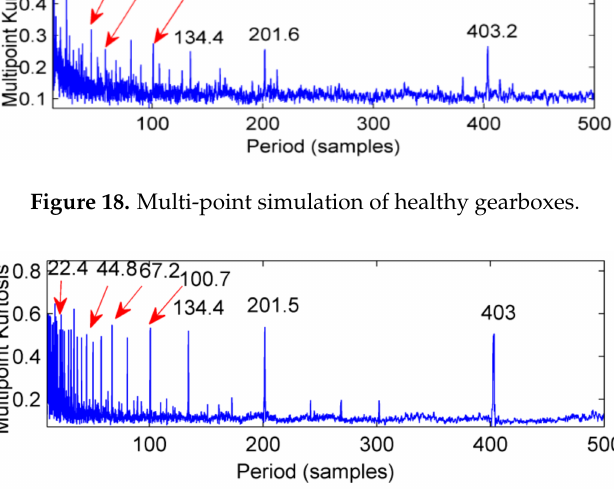
Figure 19. Faulty gearbox multi-point kurtosis